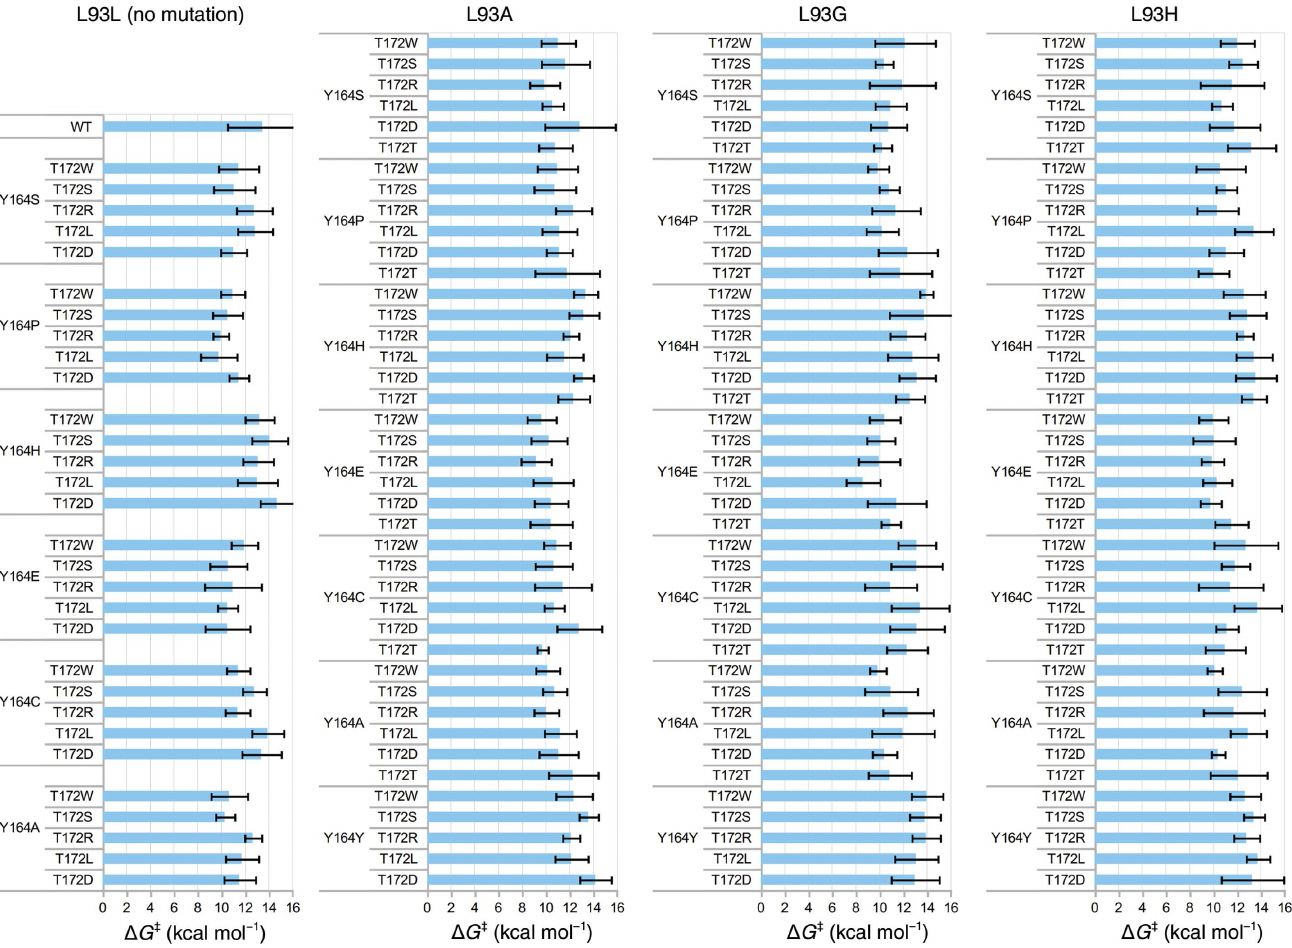
Figure 10 Results of the combinatorial saturation mutagenesis at positions 93, 164 and 172 grouped into columns based on the substitution at position 93 and further arranged into groups by substitutions at position 164. Activation energies ( (cid:2) G ‡ ) are given as the mean, with error bars showing the standard deviation over individual 24 EVB simulations. The corresponding raw data are provided in Supplementary Tables